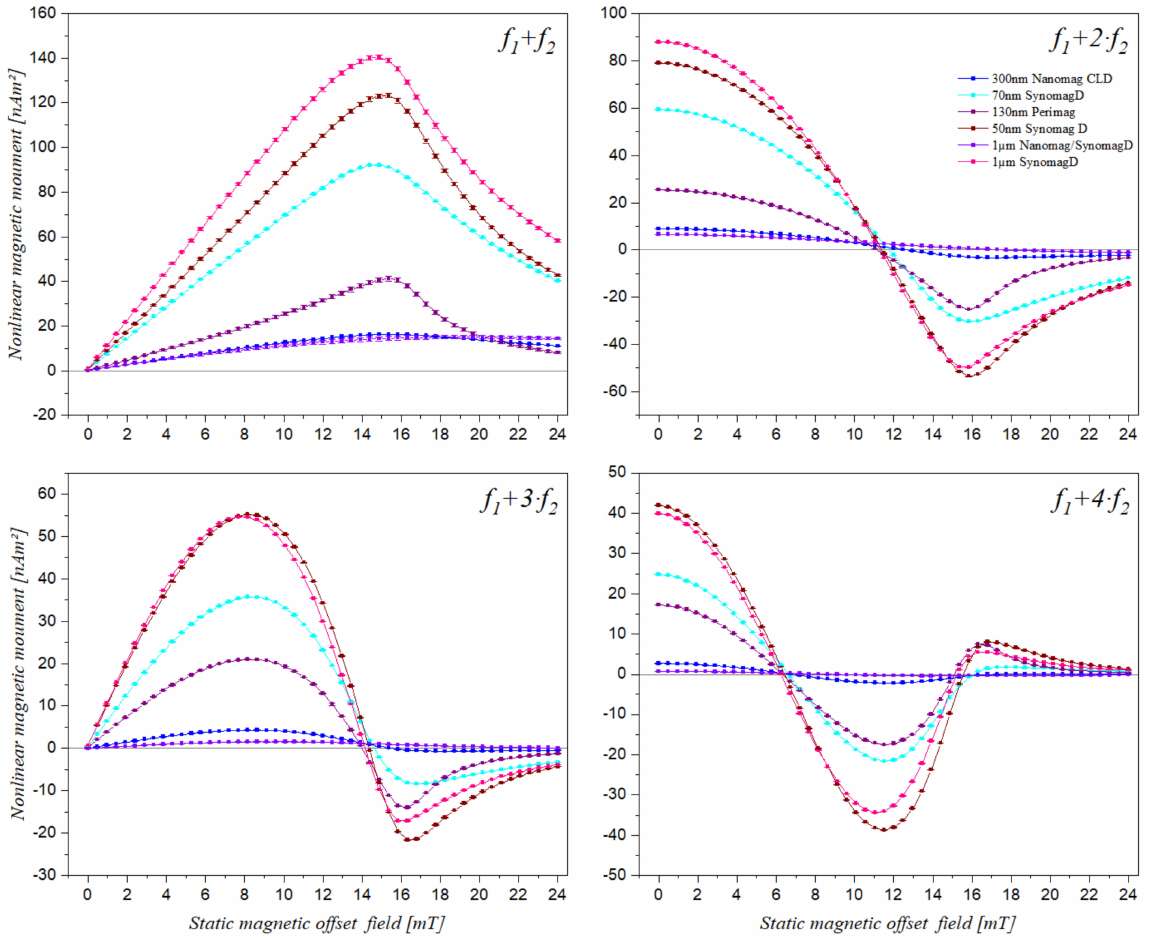
Figure 3. Measured nonlinear magnetic moment response (mean and standard deviation within point size) of different magnetic bead types at mixing frequencies f 1 + f 2 , f 1 + 2 · f 2 , f 1 + 3 · f 2 and f 1 + 4 · f 2 over a static magnetic offset field range from 0 to 24 mT. The individual points are connected by lines for visual